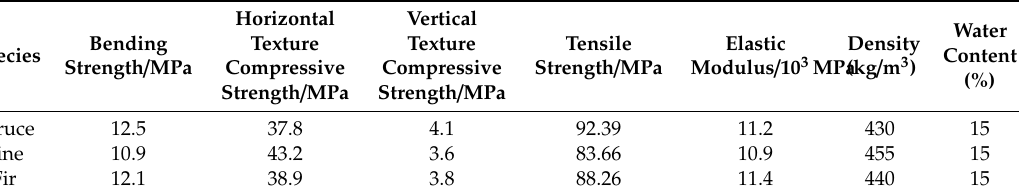
Table 2. Physical properties of spruce, pine, and fir (SPF).